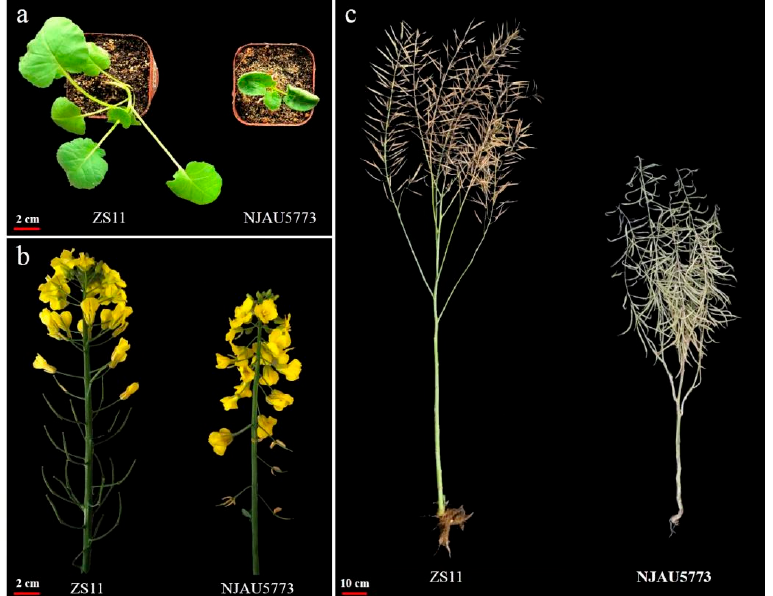
Figure 1. Performance of the parents NJAU5773 and ZS11 for constructing mapping population. ( a ) shows the leaves of the parent NJAU5773 with up-curling leaves ( right ) and the parent ZS11 with flat leaves ( left ) at the seeding stage. ( b ) shows the flowers of the parent NJAU5773 with downward-pointing flowers ( right ) and the parent ZS11 with normal flowers ( left) at the flower stage. ( c ) shows the siliques of the parent NJAU5773 with downward-pointing silique ( right ) and the parent ZS11 with upright silique ( left ) at the maturity stage.